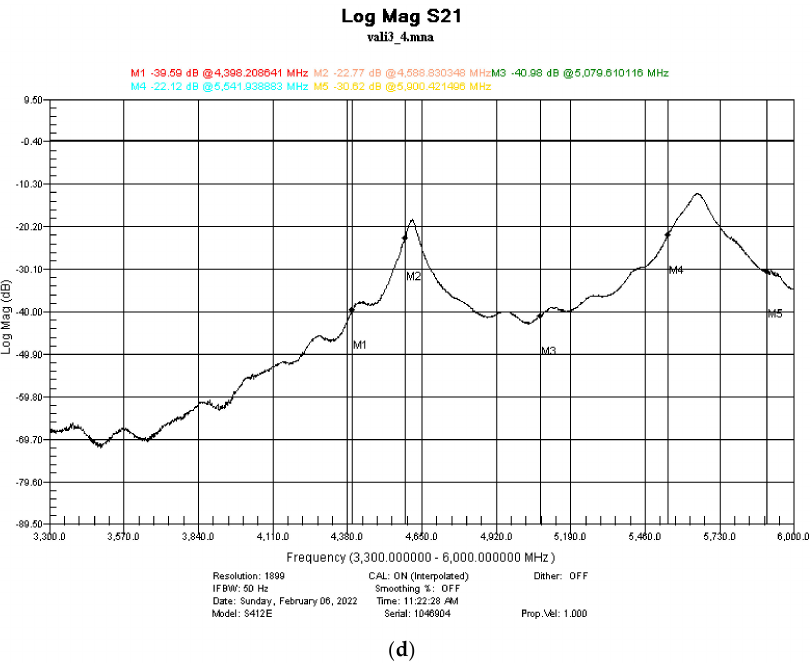
Figure 8. EMI shielding measurements in V sample and reference. ( a ) EMI-shielding measurement of reference; ( b ) EMI-shielding measurements on 1 layer of V sample; ( c ) EMI-shielding measurements on 2 layers of V sample; ( d ) EMI-shielding measurements on 3 layers of V sample.